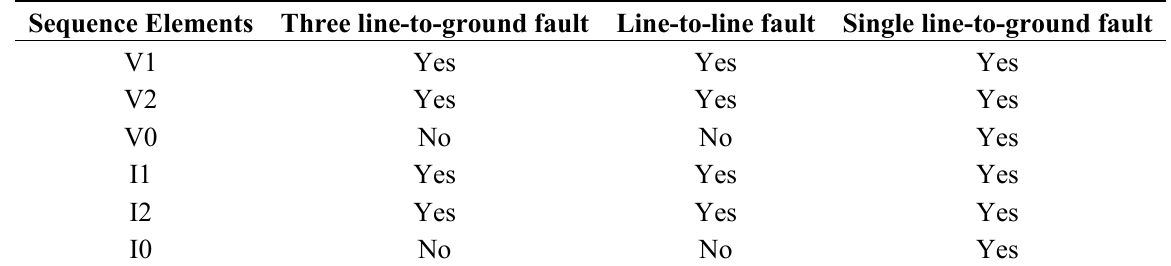
Table 1. Sequence elements used for detecting